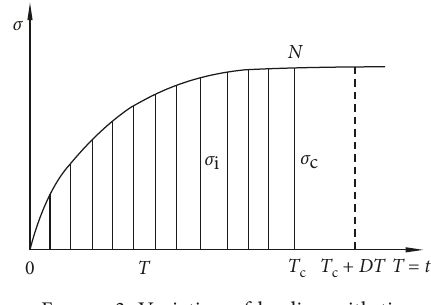
Figure 3: Variation of loading with time.